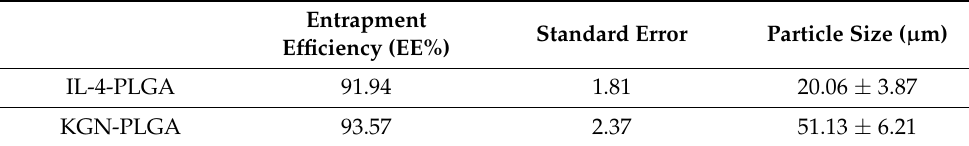
Table 1. The entrapment efficiency (EE%) and particle size of